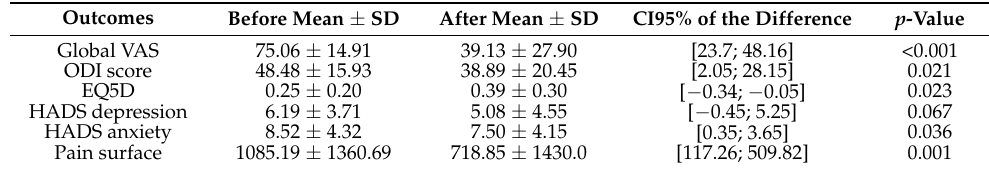
Table 3. Outcome comparisons between baseline and last follow-up visit ( n =